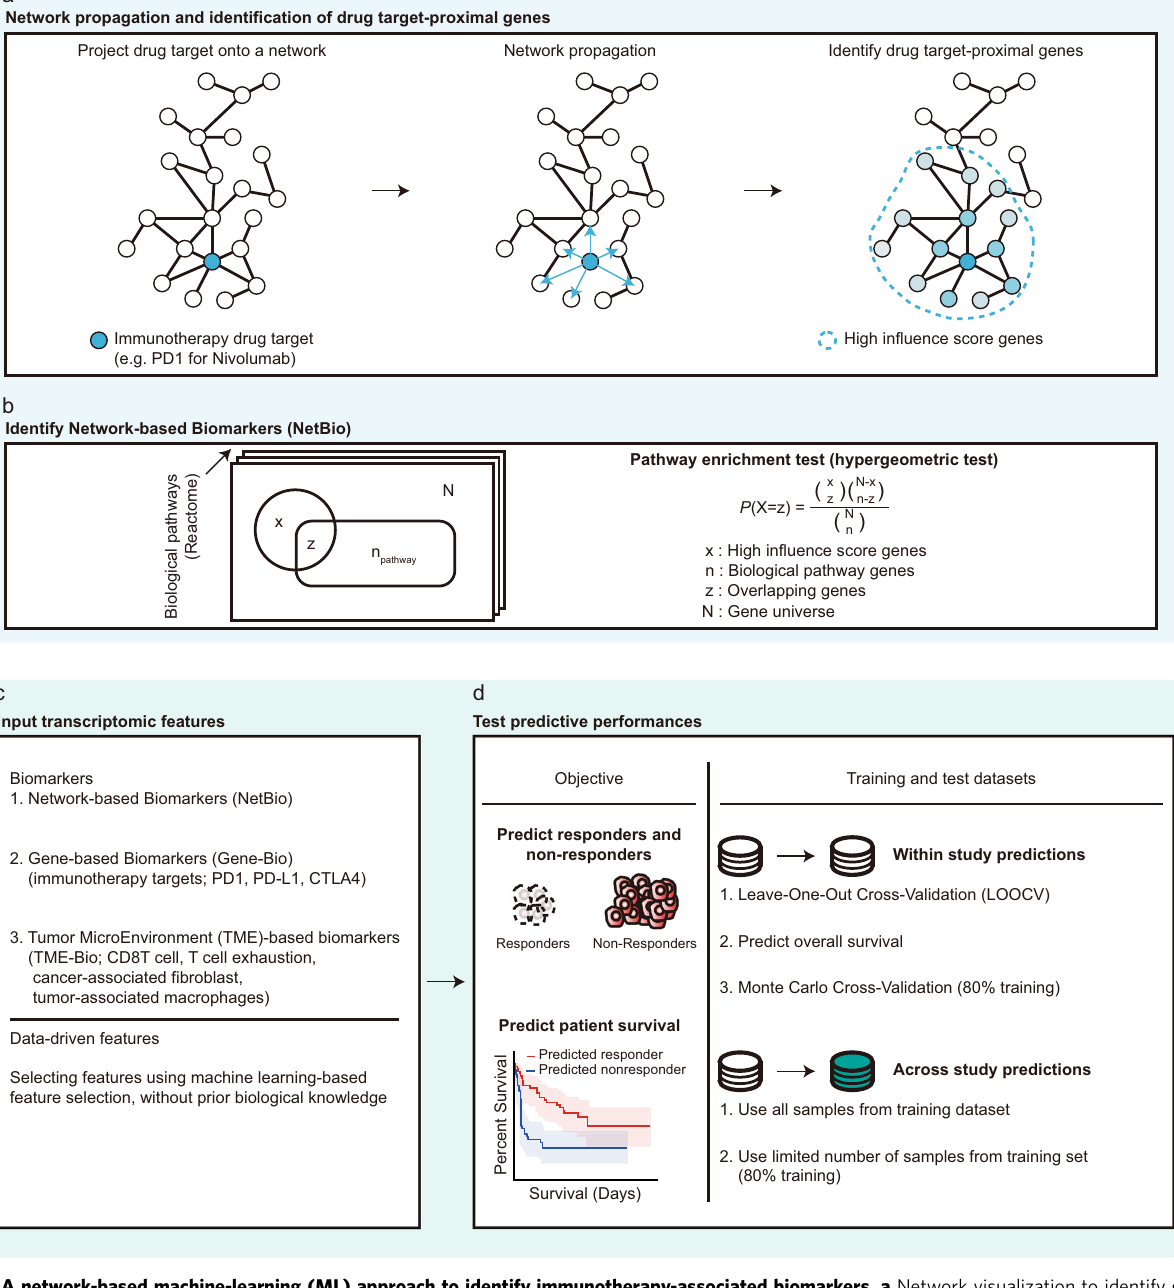
Fig. 1 A network-based machine-learning (ML) approach to identify immunotherapy-associated biomarkers. a Network visualization to identify genes proximal to immunotherapy targets in a protein-protein interaction (PPI) network. Immunotherapy targets (e.g., PD-1 for nivolumab) are displayed in blue and projected onto a PPI network, followed by network propagation using drug targets as seed genes. Network propagation is depicted as blue arrows. After propagation, drug target-proximal genes were selected by choosing nodes with high propagation scores (high-in fl uence scores). b Identifying Network-based biomarkers (NetBio). Biological pathways (Reactome) enriched with high-in fl uence score genes were selected via the hypergeometric test. c Input features used for machine learning to predict immunotherapy responders and non-responders. d Overview to measure predictive performances. For prediction objectives, we conducted predictions of the drug response and overall survival. For the training and test datasets, we conducted within-study predictions and across-study the consistency of the prediction performances. Speci fi cally, we performed (i) within-study predictions, in which training and test datasets were generated from a single cohort or (ii) across-study predictions, in which two independent datasets were used as training and test datasets (Fig. 1d). Furthermore, we alternated using large or small numbers of training samples to measure the consistency of the prediction performances under various training conditions.